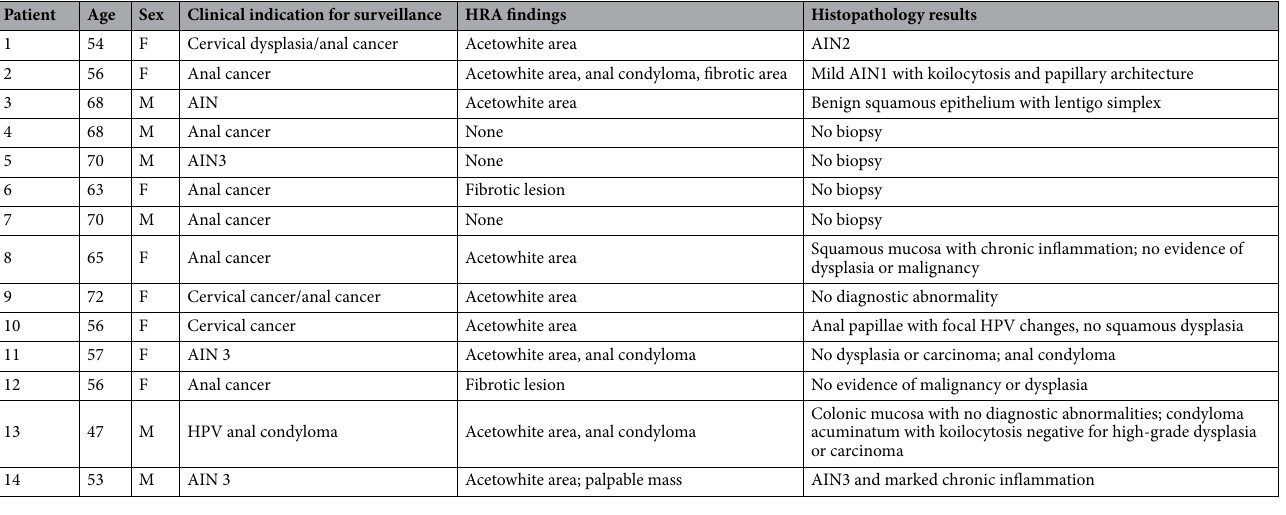
Table 1. Demographic and clinical data of